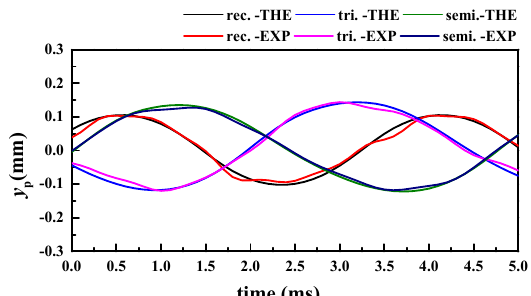
Figure 40. Vibration waveforms of different orifice shapes (MSE rec. = 9.21 × 10 −4 , MSE tri. = 8.67 × 10 −4 ,